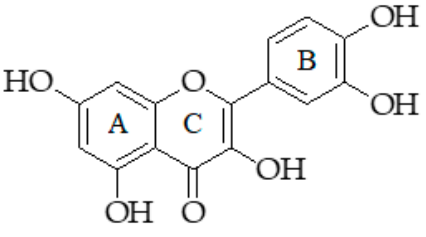
Figure 10. The chemical structure of quercetin.